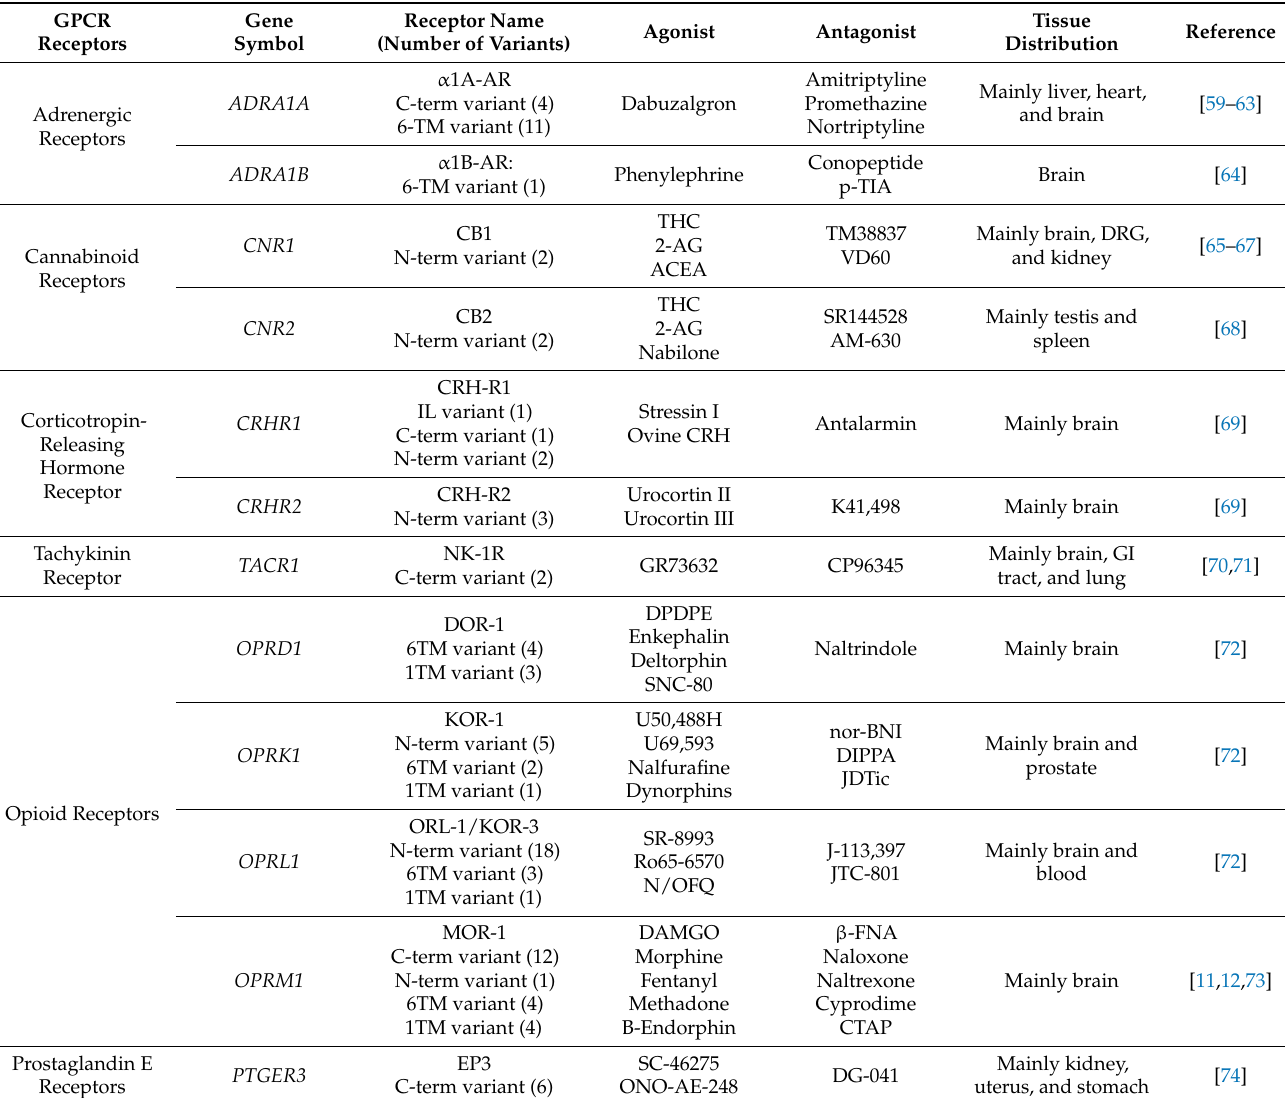
Table 1. List of selected human GPCRs splice variants along with their agonist, antagonist, and tissue distribution. GPCR